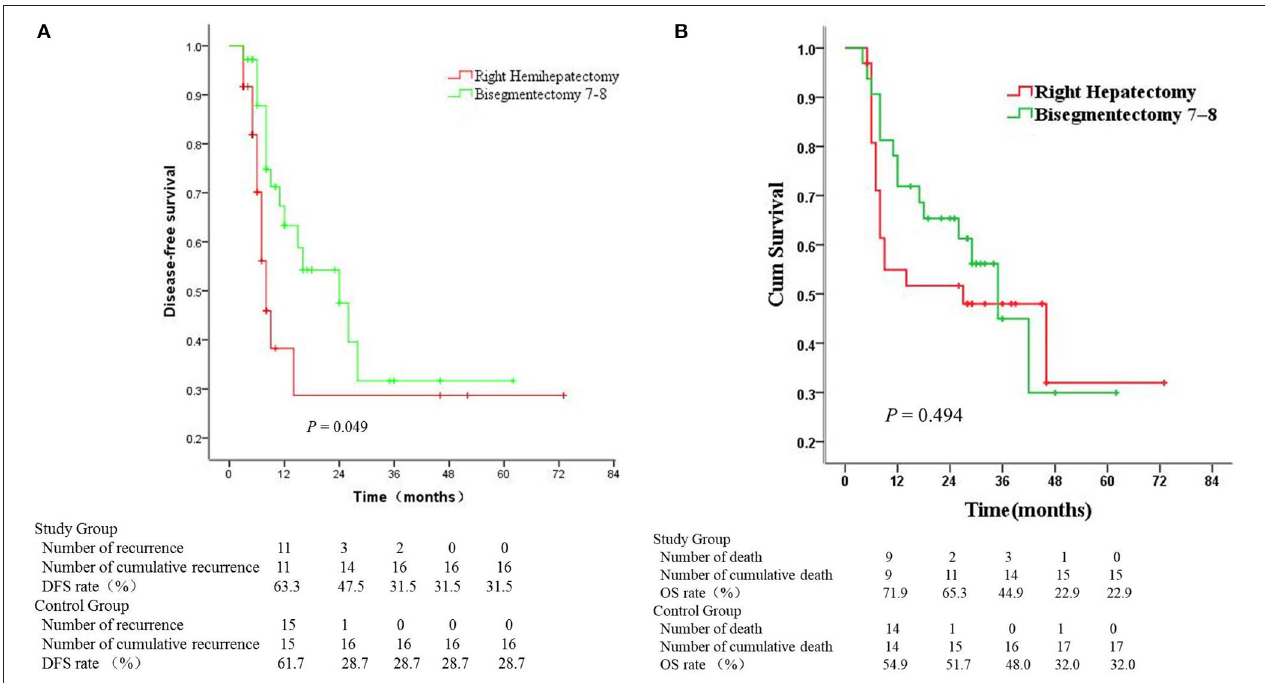
FIGURE 3 | Survival analysis in the Bisegmentectomy 7–8 Group and Right Hepatectomy Group. (A) Disease-free survival; (B) Cumulative overall survival (Bisegmentectomy 7–8 vs. Right Hepatectomy; Kaplan–Meier, log–rank